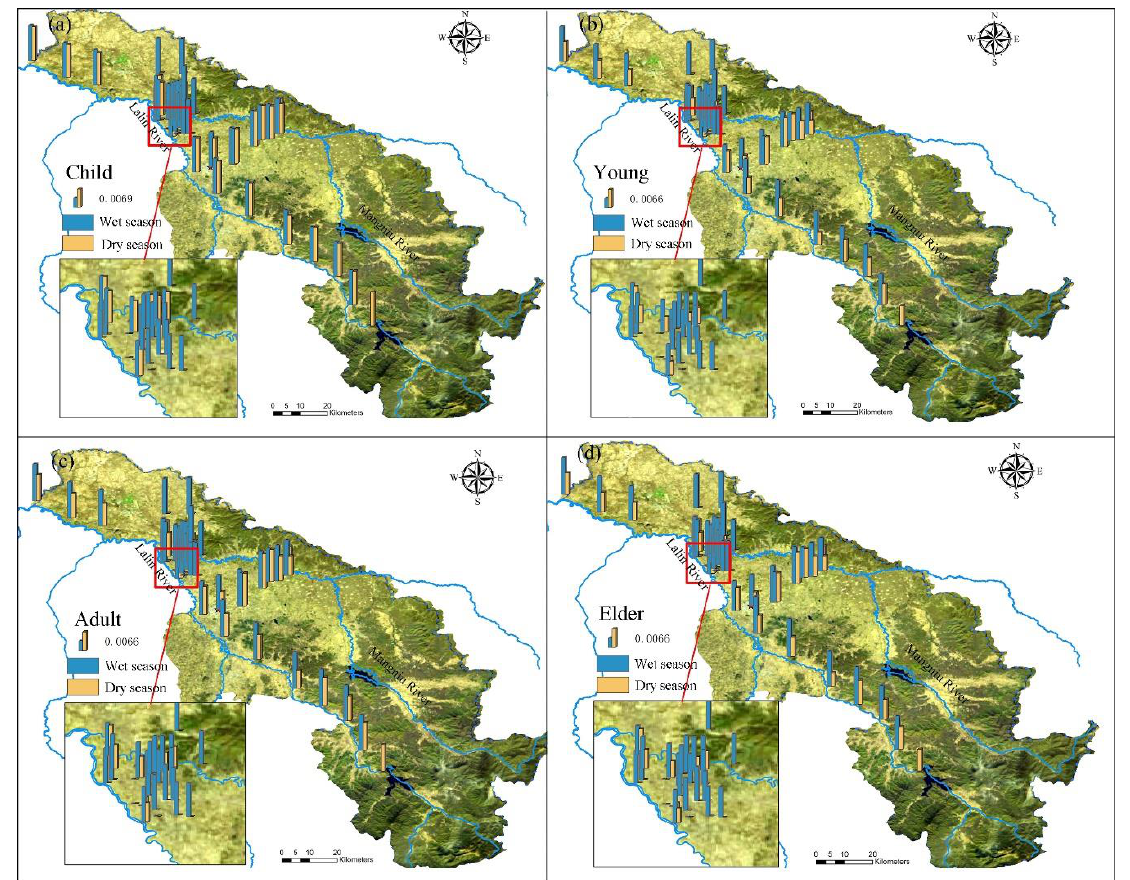
Figure 3. Spatial distribution of R-values: ( a ) child, ( b ) young, ( c ) adult, ( d ) elder.